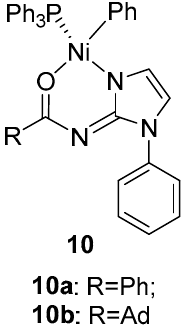
Figure 8. Imidazol-2-ylacylamide nickel catalysts 10a , b ( Ad = adamantyl).